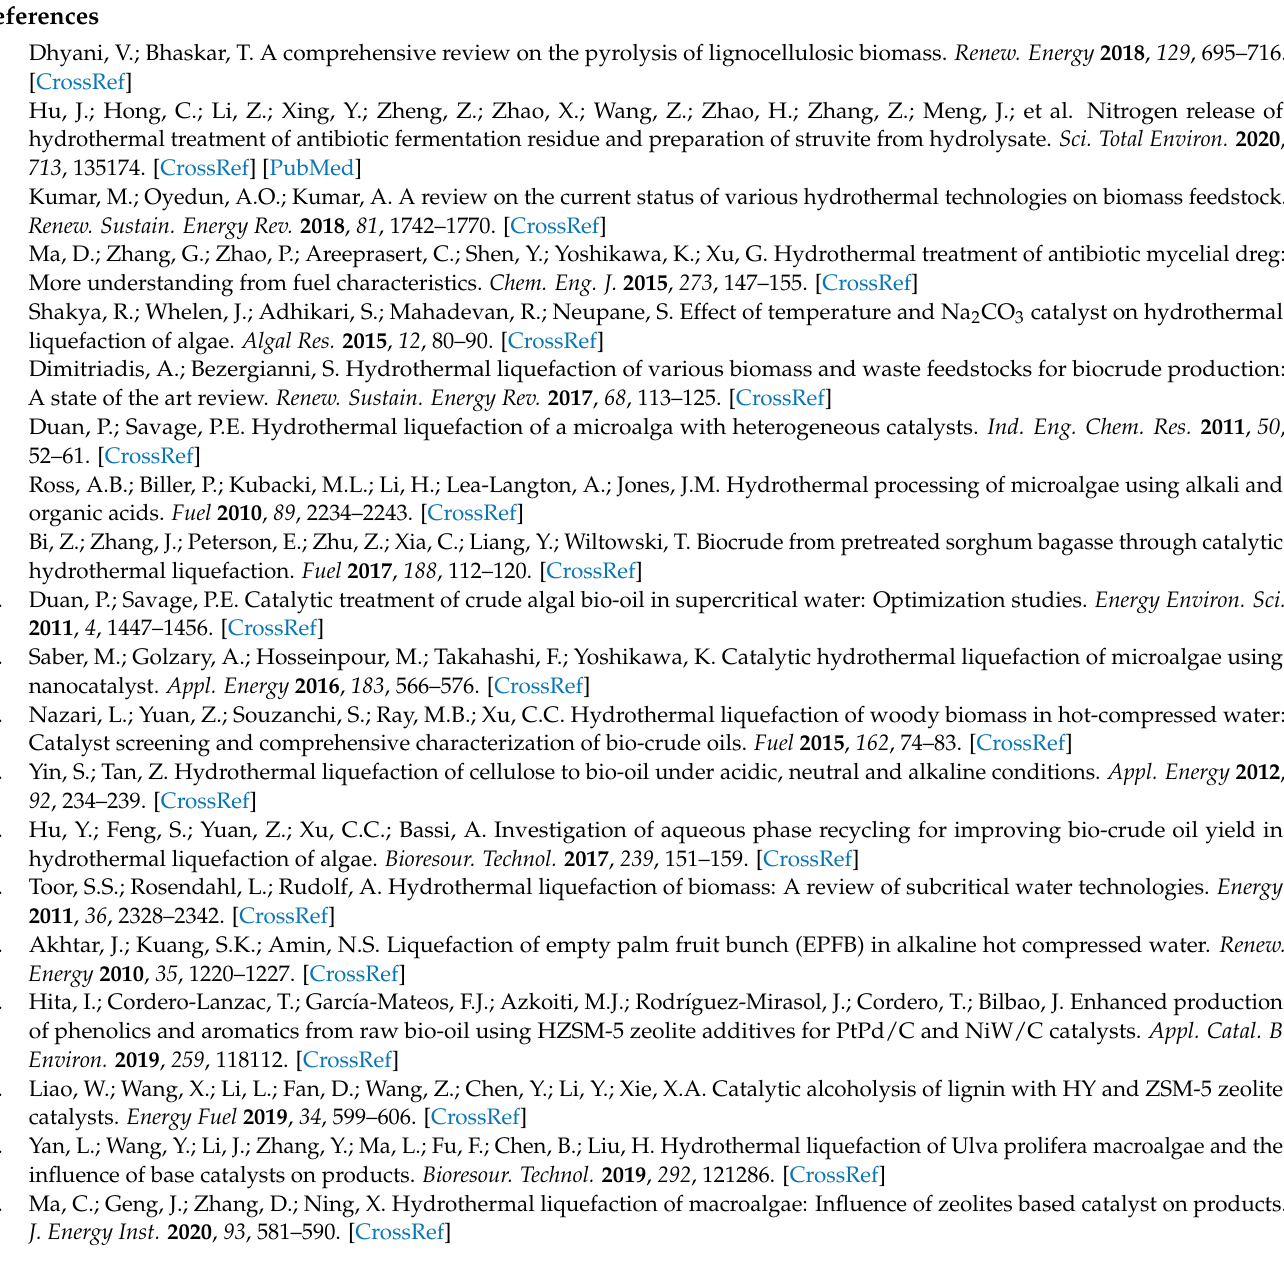
Table S2: The main organic compound components of bio-oil (Na 2 CO 3 , NaOH), Table S3: The main organic compound components of bio-oil (ZSM-5,